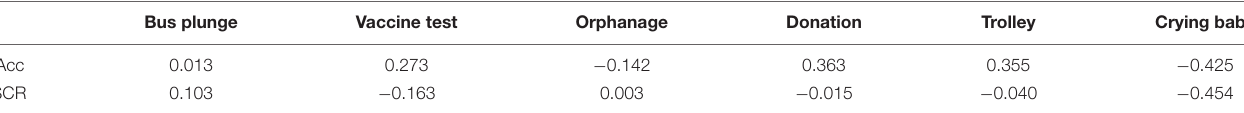
TABLE 2 | Effect of IAcc and SCR on moral